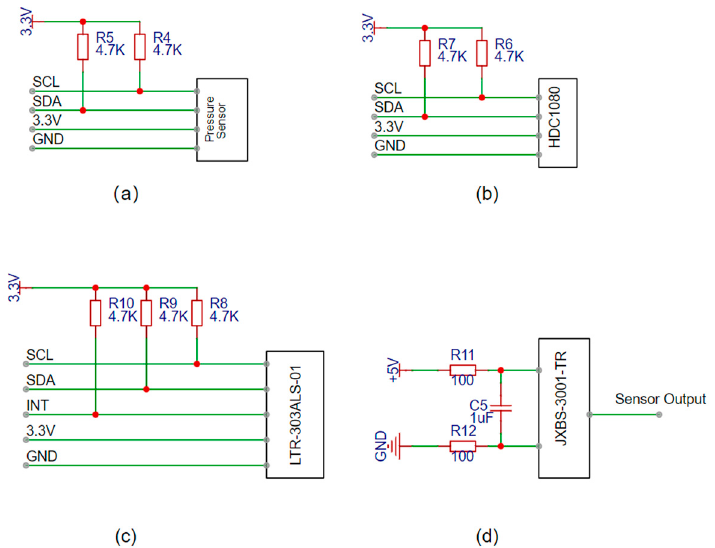
Figure 6. Sensor Interface Circuit: ( a ) Interface circuit of expansion probe. ( b ) Temperature and humidity monitoring module circuit. ( c ) Light-intensity monitoring module circuit. ( d ) Soil moisture sensor.